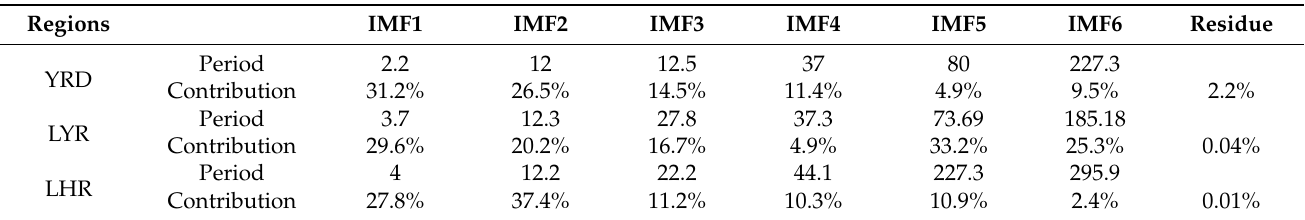
Table 2. Periods and variance contribution of IMFs and the residues of TSI in the YRD, LYR, and LHR. (The unit of the period is a month, such that 3.7 months is an approximately seasonal period and 12.3 months is an approximately interannual periodicity. Residue indicates the general trends of